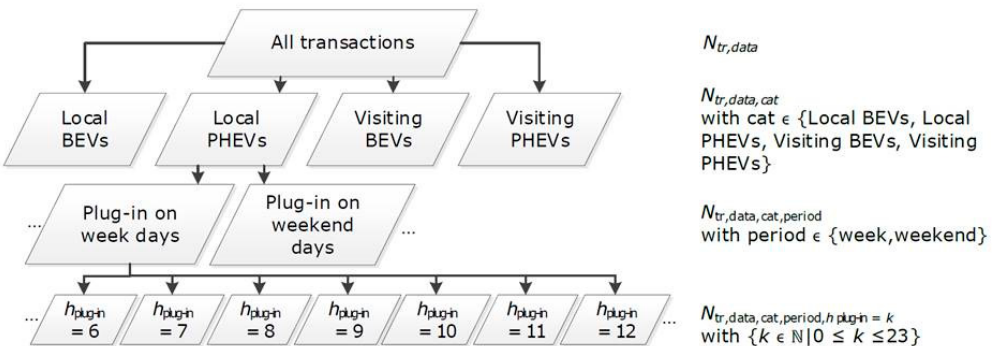
Figure 3. Division of transactions. The dots indicate parts of the division tree that are not shown. The corresponding number of transactions in each set is given at the right of the figure.